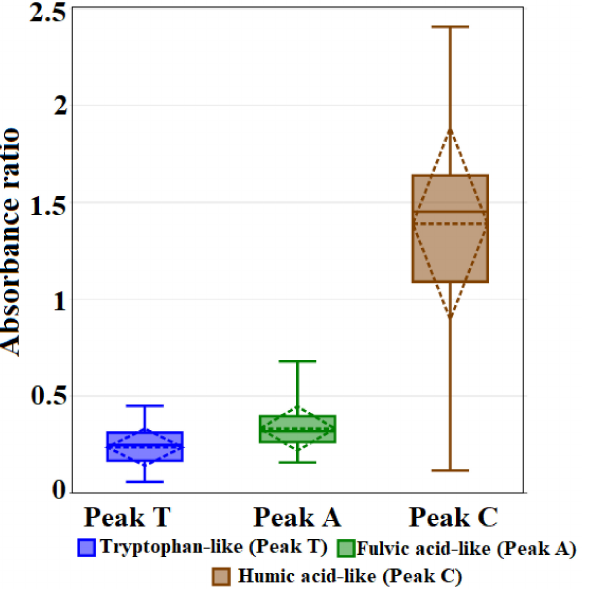
Figure 5. Box and whisker plot of fluorescence peaks such as tryptophan-like, fulvic acid-like, and humic acid-like